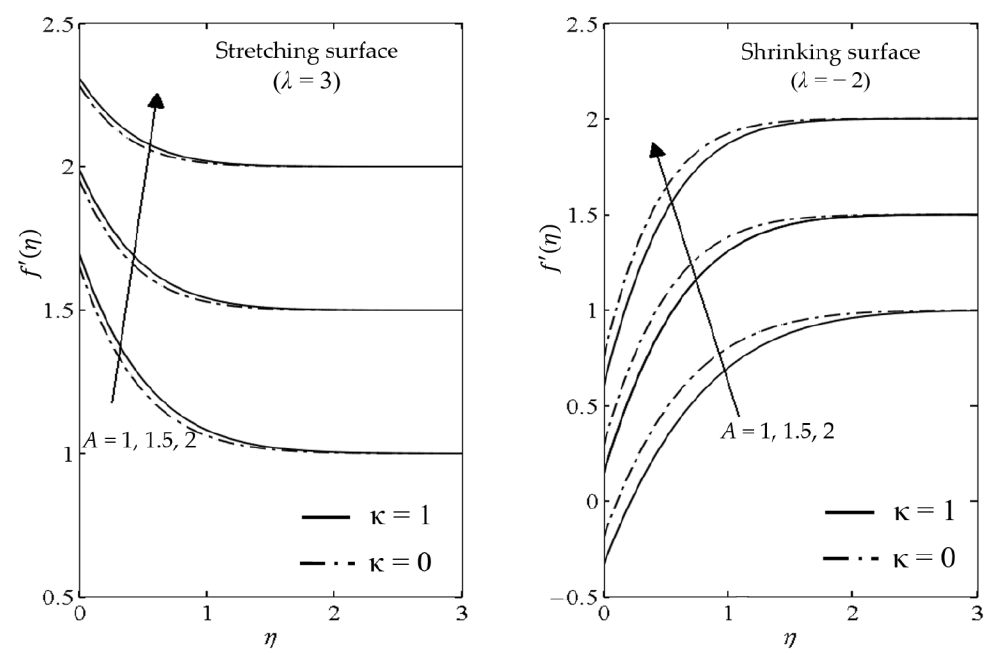
Figure 11. Effect of the thermal slip parameter, δ T , on the temperature profiles for different parameters κ and λ .